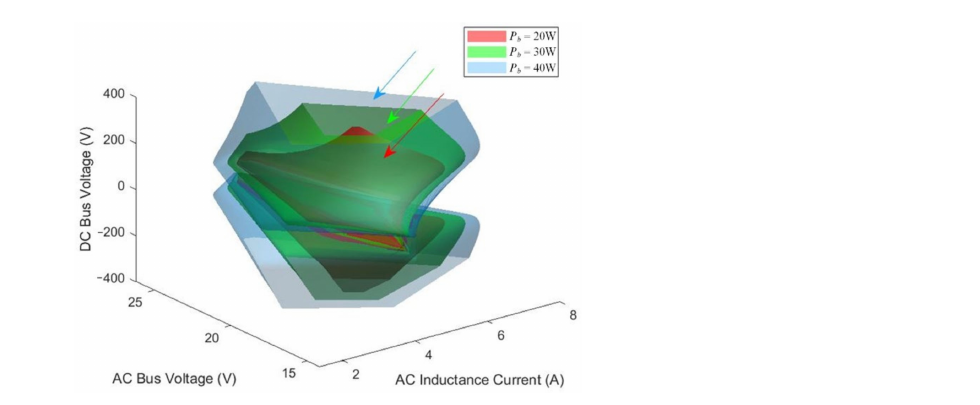
Figure 23. Different 3D RAS of microgrids when battery discharging powers are 20 W, 30 W and 40 W.